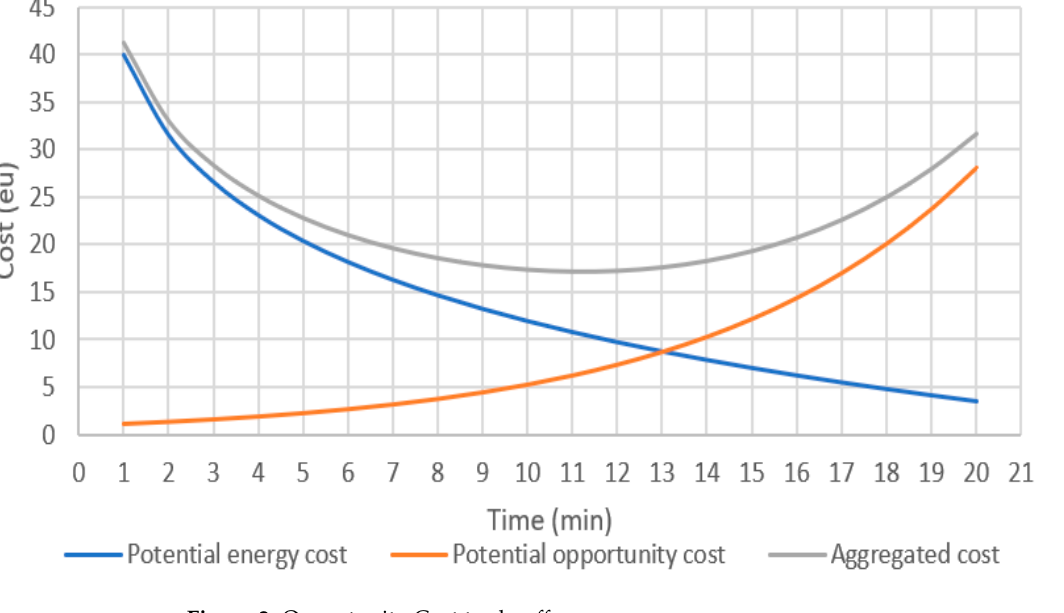
Figure 2. Opportunity Cost trade-off.